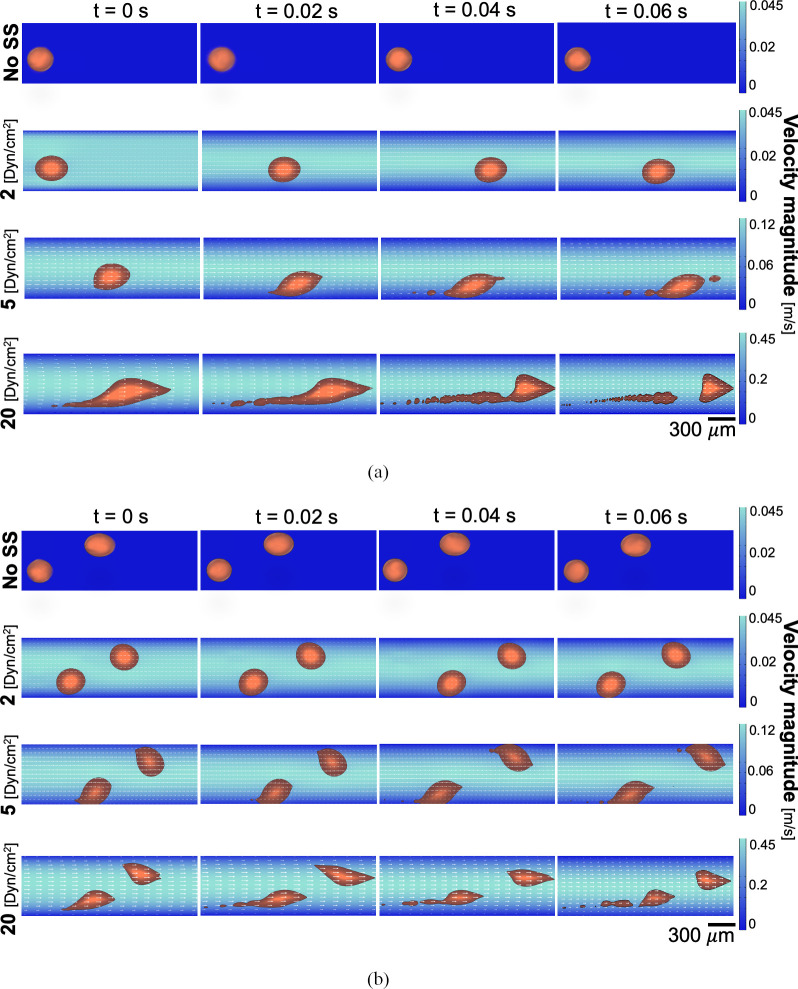
CTC clusters disaggregation.Fluid-dynamic simulation of CTC clusters disaggregation process under fluid flow with (A) one and (B) two clusters circulating. Clusters shape inside the vessel is reported at different time points: t = 0, 0.02, 0.04 and 0.06 s.